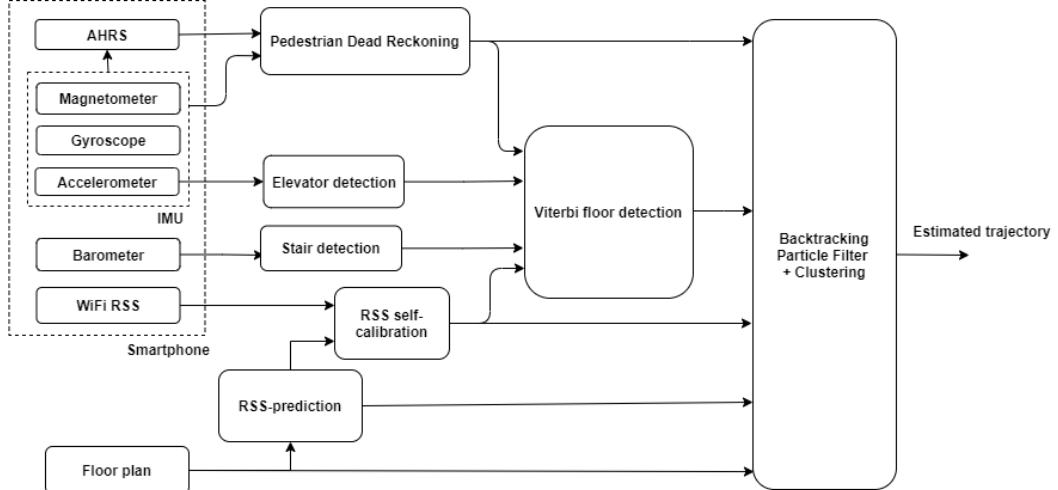
Figure 1. High-level flowgraph of the